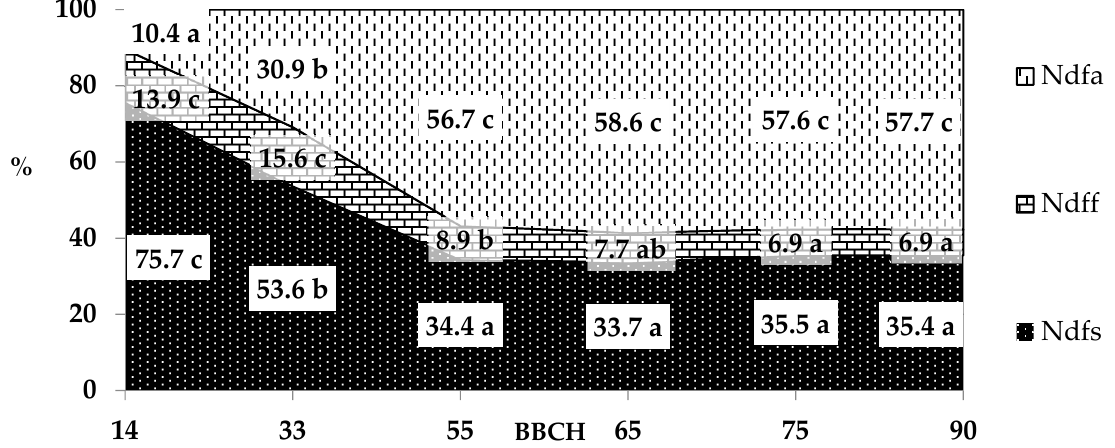
Figure 2. Percentage of nitrogen uptake by pea from different sources (Ndfa—from atmosphere, Ndff—from fertilizer, Ndfs—from soil) in following growth stages, % (meanly from three replications, pea cultivars and years of research), a, b, c, …—averages for the same sources of nitrogen with different letters are significantly different.